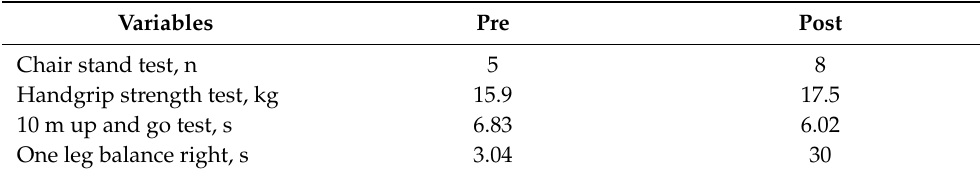
Table 5. Functional test values before and after the intervention. Variables Pre Post